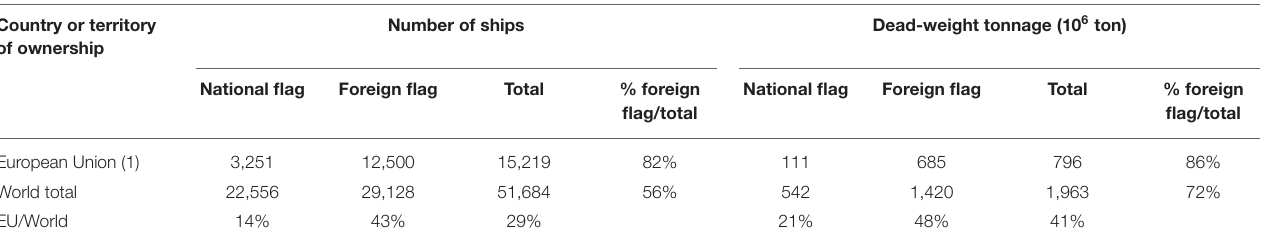
Number of ships